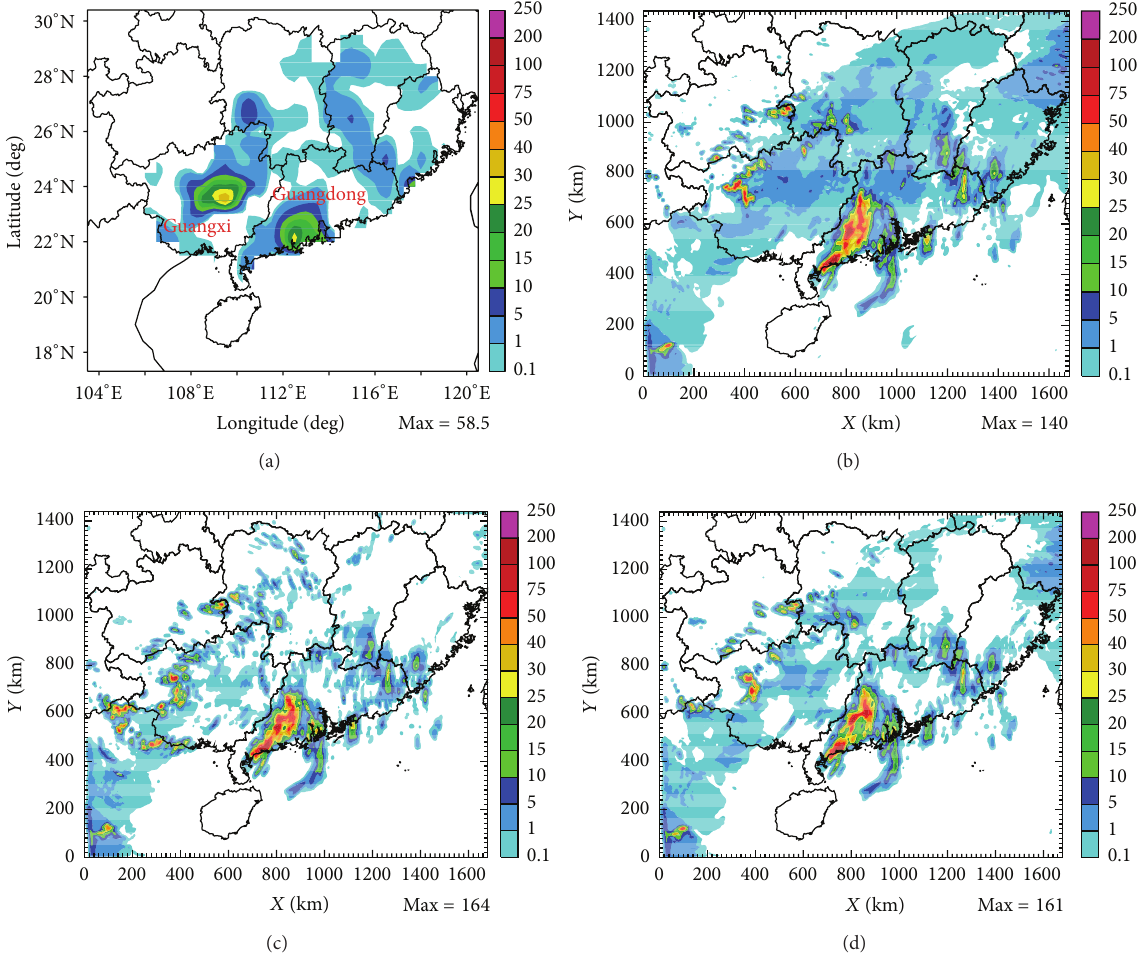
Figure 4: 3h accumulated precipitation from (a) observations, (b) CNTL, (c) RADSND, and (d) ALLDATA between 1200 and 1500 UTC June 29, 2011 for case